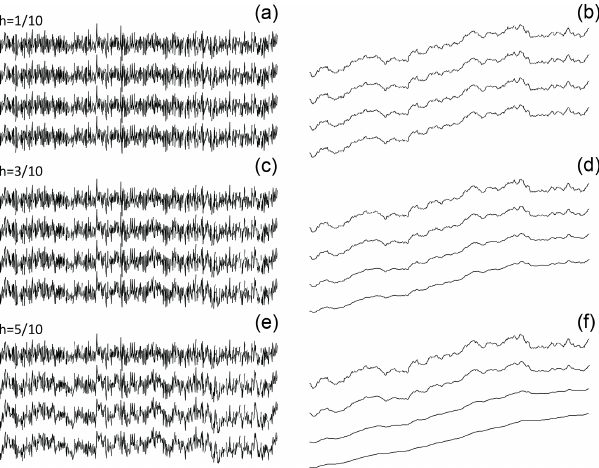
Figure 8. This set of simulations is similar to Fig. 6 ( (a, c, e) fRn, (b, d, f) fRm) except that instead of making a large simulation and then degrading and zooming, all the simulations were of equal length (2 10 points) but resolutions τ = 2 − 15 , 2 − 10 , 2 − 5 , and 1 (bot- tom to top). The simulations therefore spanned the ranges of scale 2 − 15 to 2 − 5 , 2 − 10 to 1, 2 − 5 to 2 5 , and 1 to 2 10 , and the same ran- dom seed was used in each so that we can see how the structures slowly change when the relaxation scale changes. The bottom fRn, h = 5 / 10 set is the closest to that observed for the Earth’s temper- ature, and since the relaxation scale is of the order of a few years, the second series from the top of this set (with 1 pixel = 1 month) is close to that of monthly global temperature anomaly series. In that case the relaxation scale would be 32 months and the entire series would be 2 10 / 12 ≈ 85 years long. The top series (of total length 2 10 relaxation times) is (nearly) a white noise (a, c, e) and Brown- ian motion (b, d, f) , and the bottom is (nearly) an fGn (a, c, e) and fBm (b, d, f) . The total range of scales covered here (2 10 × 2 15 ) is larger than in Fig. 5a and allows one to more clearly distinguish the high- and low-frequency regimes.